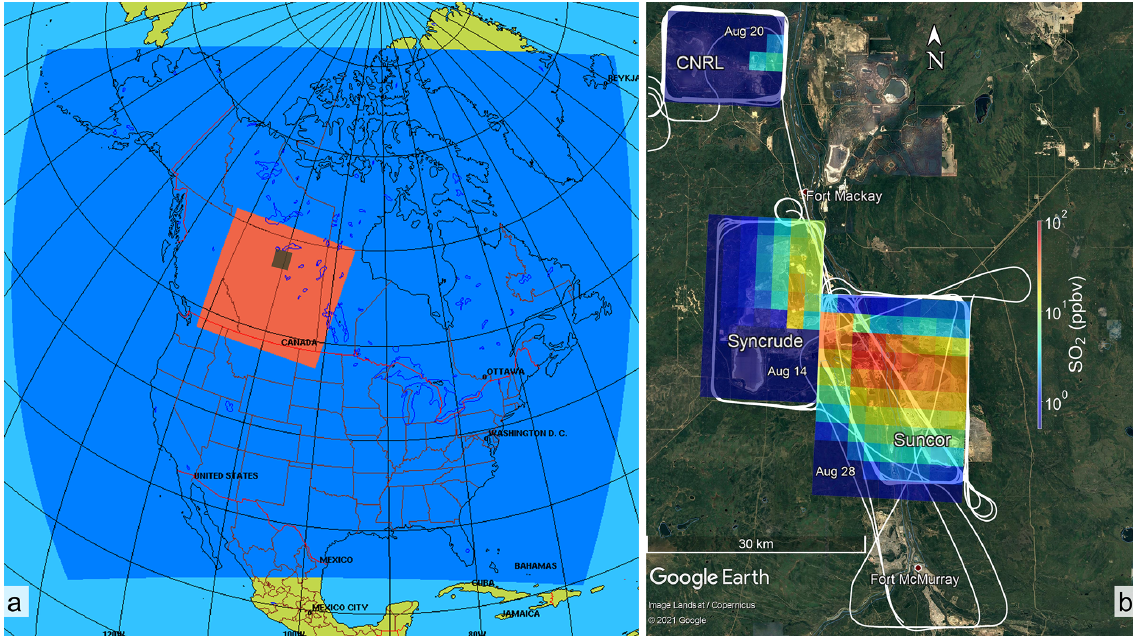
Figure 1. (a) GEM-MACH model horizontal grid structure with nested domains: the dark blue region shows the parent domain over North America at 10km horizontal grid resolution. Output from GEM-MACH 10km simulations provided initial and boundary conditions for the nested high-resolution GEM-MACH 2.5km domain (red). The high-resolution domain was configured over the Canadian provinces of Alberta and Saskatchewan including the Alberta Athabasca oil sands region, shown as a dark shaded area. (b) © Google Earth map of the region with three oil sands facilities labelled. JOSM 2013 flight tracks on 14, 20 and 28 August are drawn with white curves. Model 4D fields were extracted for nine JOSM 2013 box flight cases over these three facilities, examples are shown as overlay SO 2 concentration